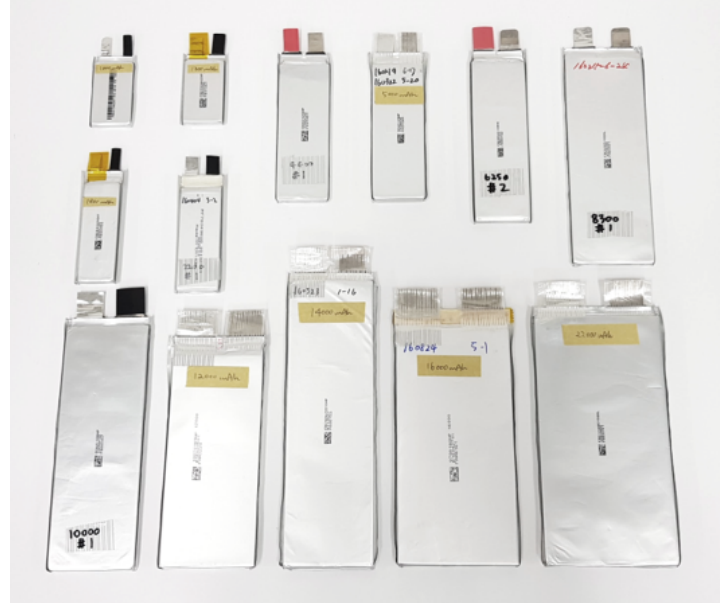
Figure 11. Single cell LiPo battery battery